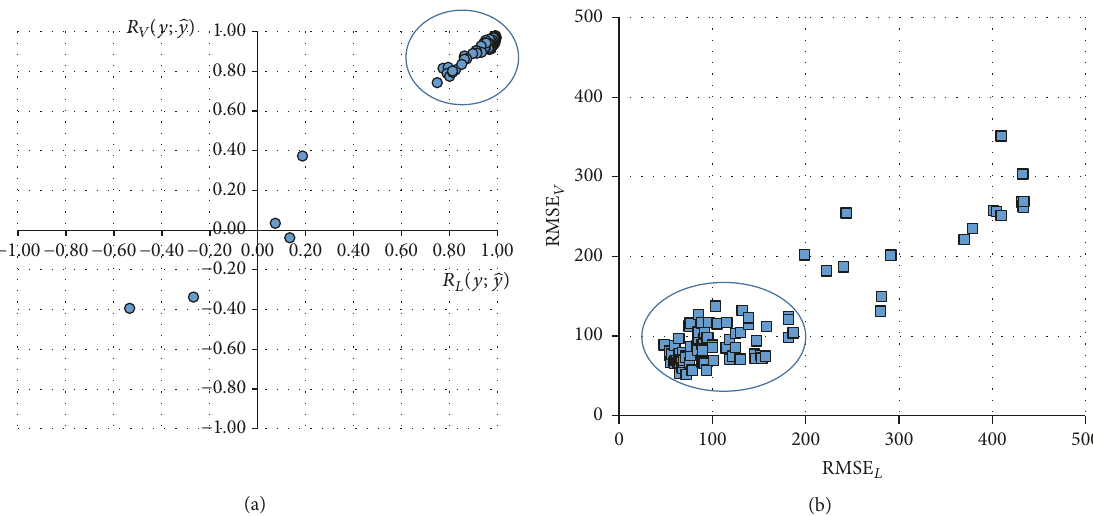
Figure 3: Quality end errors of ANNs after the initial training phase: (a) scatter diagram of Pearson’s correlation coefficients and (b) scatter diagram of errors ( RMSE ) ; 𝐿 and 𝑉 stand for learning and validating subsets accordingly (source: own study).